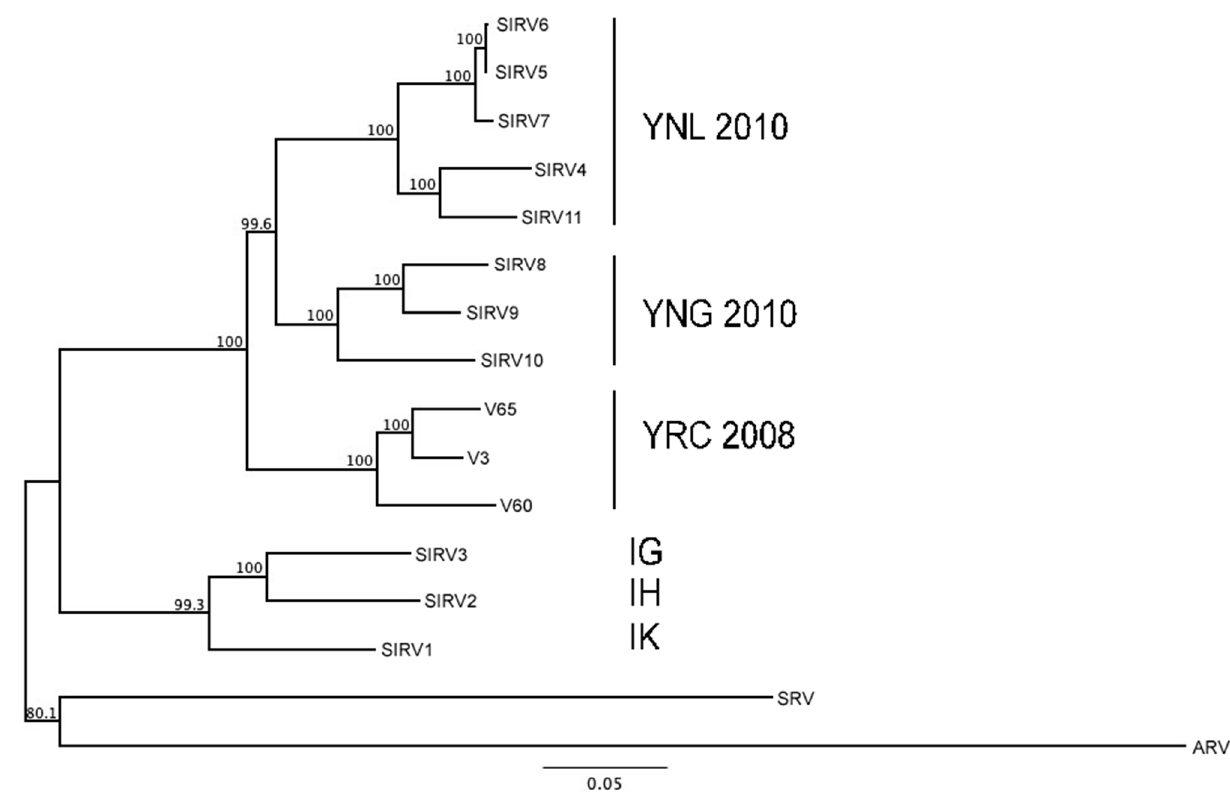
Figure 3. Relatedness of viral isolates. Genome sequences of the indicated viruses were analyzed by progressive MAUVE (see Section 2). Abbreviations: ARV, Acidianus Rod-shaped Virus 1 (NC_009965.1); SRV, Stygiolobus Rod-shaped Virus (NC_025375.1). GenBank accession numbers for SIRV1–11 are NC_004087.1, NC_004086.1, NC_030884, KY744231, KY744233, KY744235, KY744232, KY744229, KY744228, KY744230, and KY744234, respectively. Geographical regions are indicated as follows: YNL, Yellowstone National Park (Nymph Lake); YNG, Yellowstone National Park (Norris Geyser Basin); YRC, Yellowstone National Park (Rabbit Creek); IG, Iceland (Gunnuhver); IH, Iceland (Hveragerdi); IK, Iceland (Kverkjoll). If known, the year of isolation is also shown with location; for additional details, see Table 1.